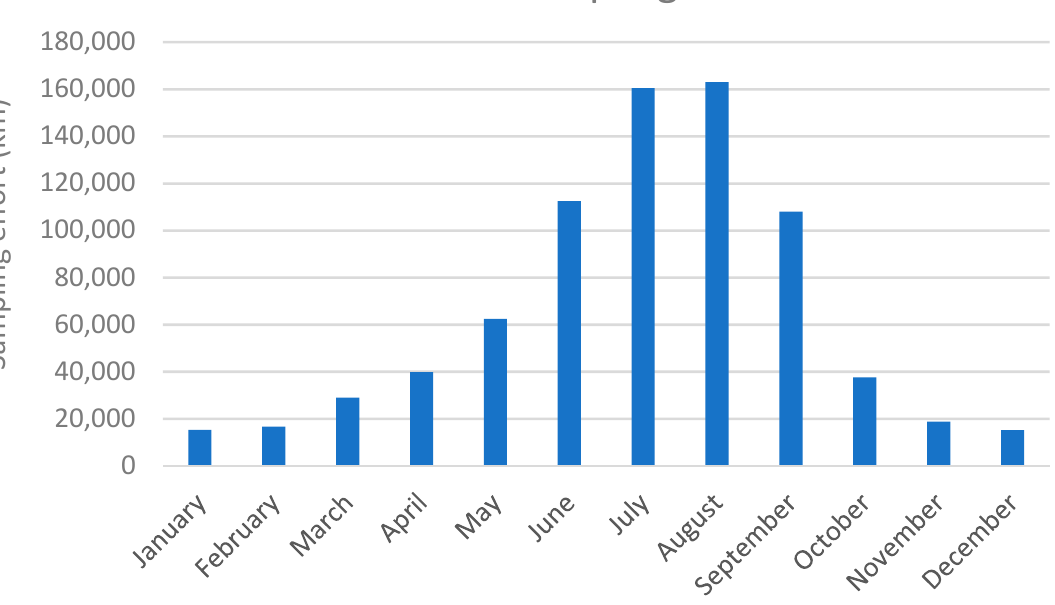
Figure 2. The cumulative sampling effort performed by the research units per month.